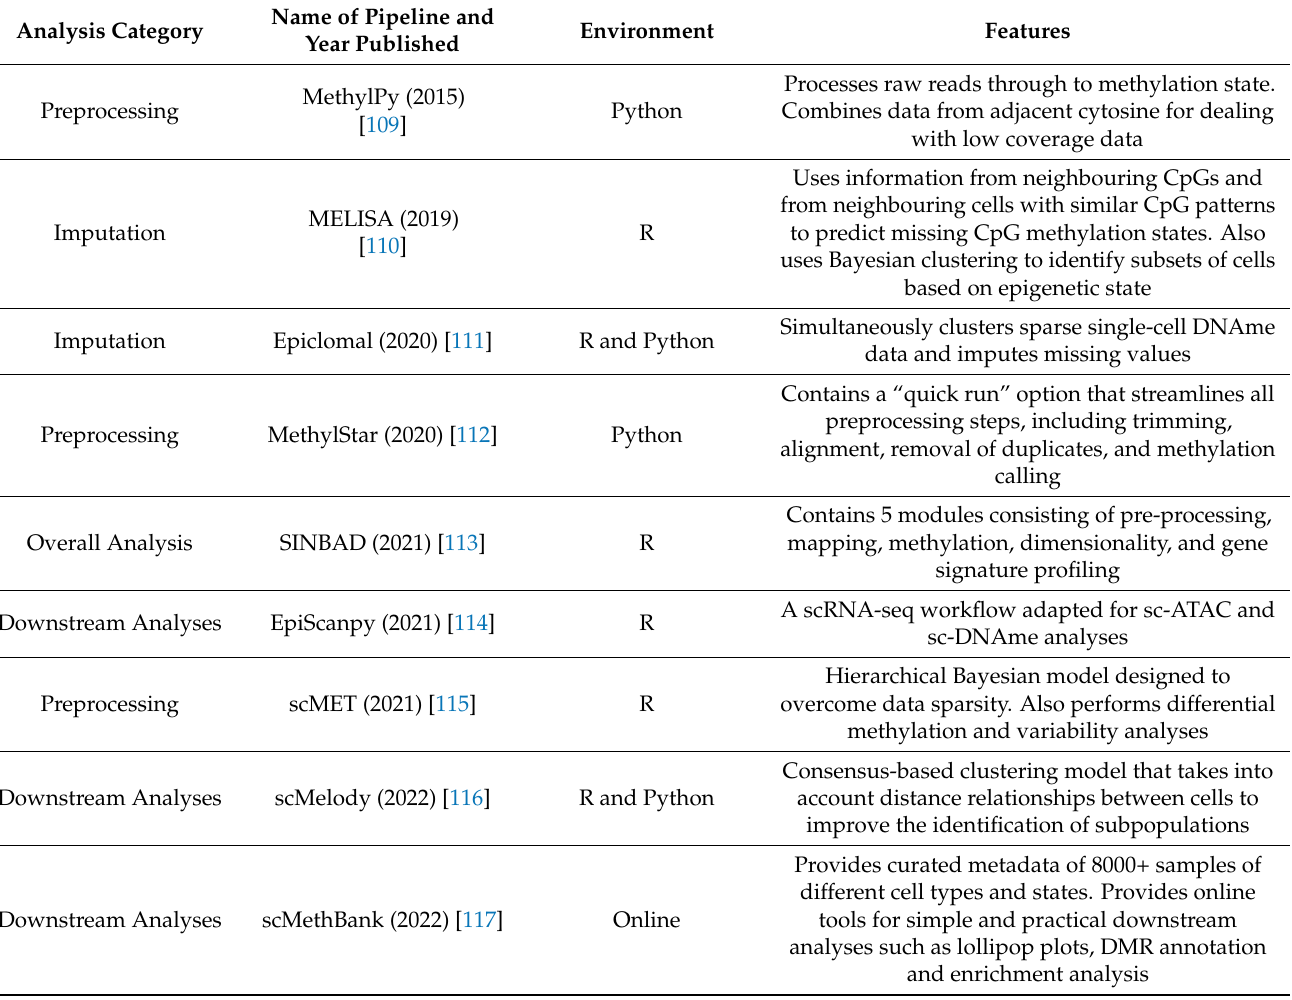
Table 3. methylation